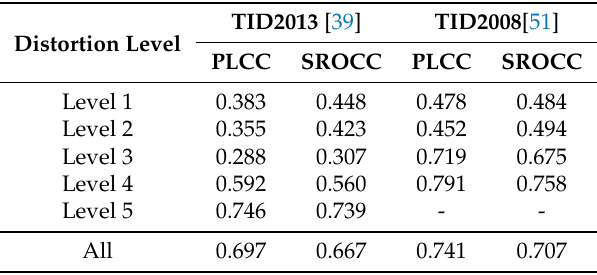
Figure 9. Comparison of different regression methods (SVR with Gaussian kernel function, SVR with linear kernel function, GPR with squared exponential kernel function, GPR with rational quadratic kernel function, BTR, and RFR). Mean PLCC and SROCC values were measured over 20 random train-test splits on TID2008 [51]. Table 3. Average PLCC and SROCC values of the proposed method for each distortion level of TID2013 [39] and TID2008 [51].